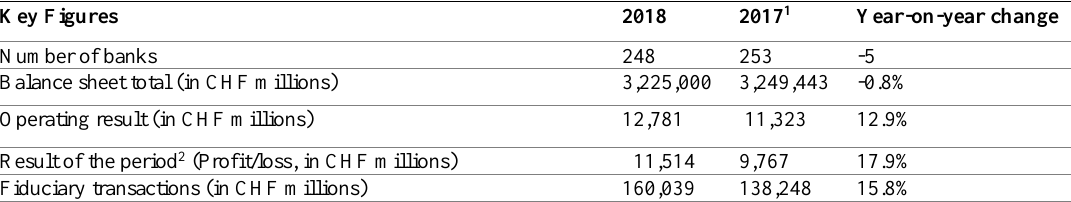
Table 1: Key figures for Swiss Banking industry (Swiss National Bank, 2018. pg.